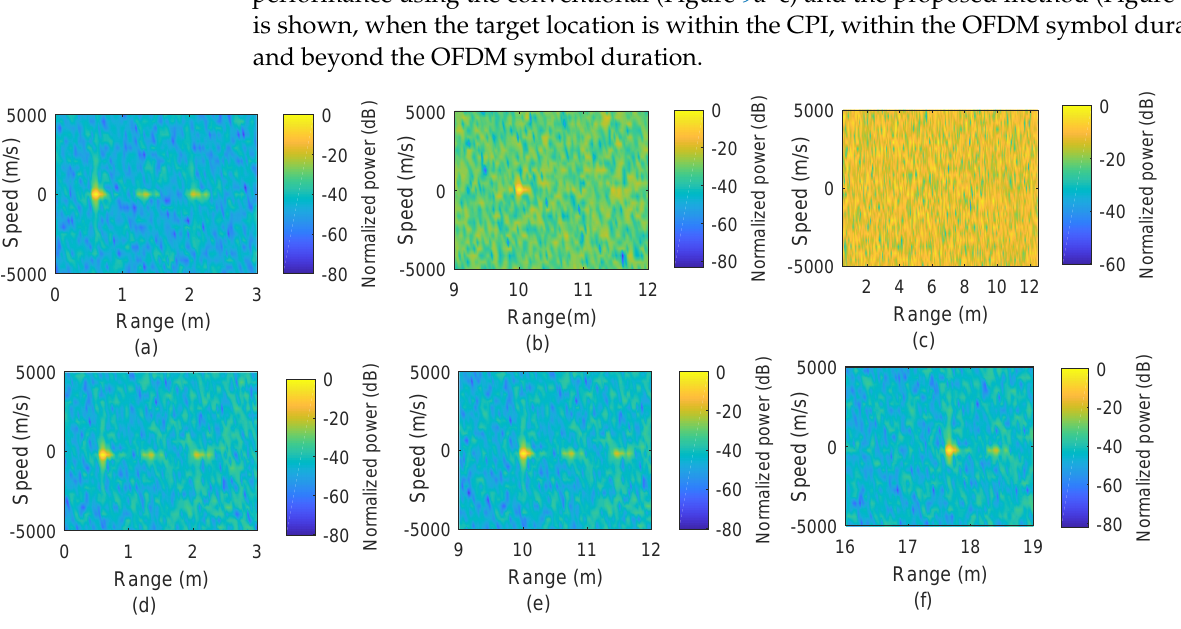
Figure 9. Range extension of the measurement results, where the range is extended through offset– delay. ( a – c ) Results of conventional approach for targets at 0.6 m, 10 m, and 17.65 m, respectively. ( d – f ) Results obtained through the proposed range extension method for the arrangements as for results in ( a – c